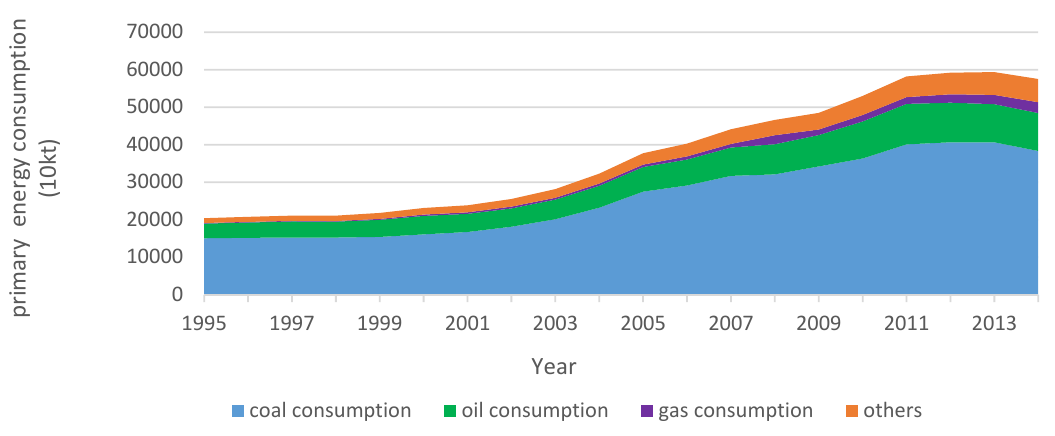
Figure 1. The total of primary energy consumption in the Beijing-Tianjin-Hebei region from 1995 to 2014. Figure source: The dates of primary energy consumption of various fossil energy types (1995–2014)